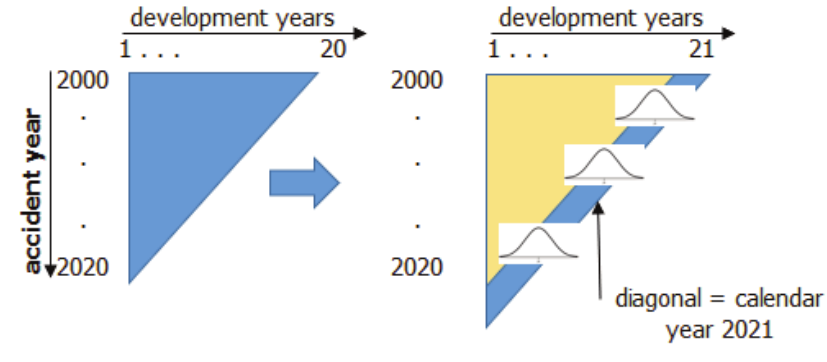
Fig. 2. One-year best estimate (based on Boumezoued et al.